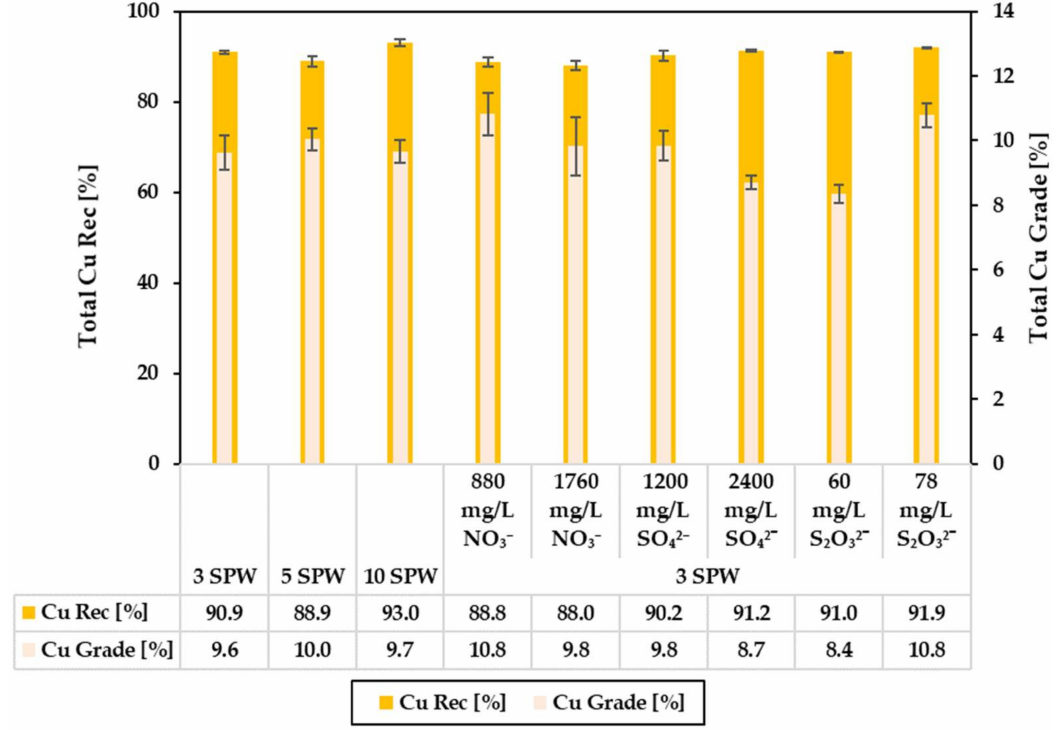
Figure 3. Copper Rec and grade at different anion concentrations, where ‘Rec’ refers to recovery. The variation of the nickel recovery and associated grade at different synthetic plant water conditions is shown in Figure 4. Increasing the ionic strength of water through 3, 5 and 10 SPW resulted in a dip in nickel recovery at 5 SPW, with 10 SPW recovering most of the nickel. An interesting phenomenon was observed at 5 SPW; although it had a considerably low nickel recovery compared to 3 SPW, it exhibited better nickel grade compared to 3 and 10 SPW. Spiking 3 SPW with 352 mg/L and 1232 mg/L NO 3 − results in nickel recoveries of 73.0% and 72.4%, respectively, compared to 74.0% observed at 3 SPW. NO 3 − did not seem to have a pronounced effect on the recovery of nickel. There was no significant recovery difference between 3 SPW containing 880 mg/L and 1760 mg/L NO 3 − . SO 42 − and S 2 O 32 − spiking showed recoveries of nickel to be in the same